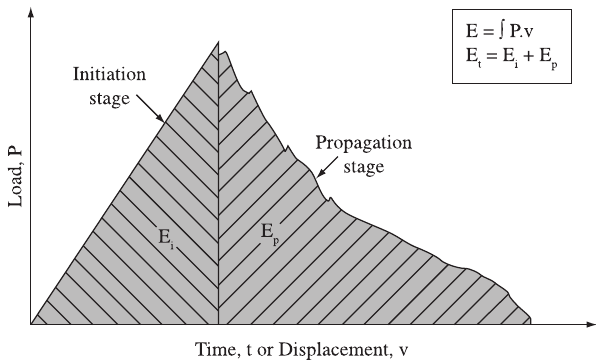
Figure 3. Typical two-stage curve obtained in instrumented Charpy impact testing 9 .